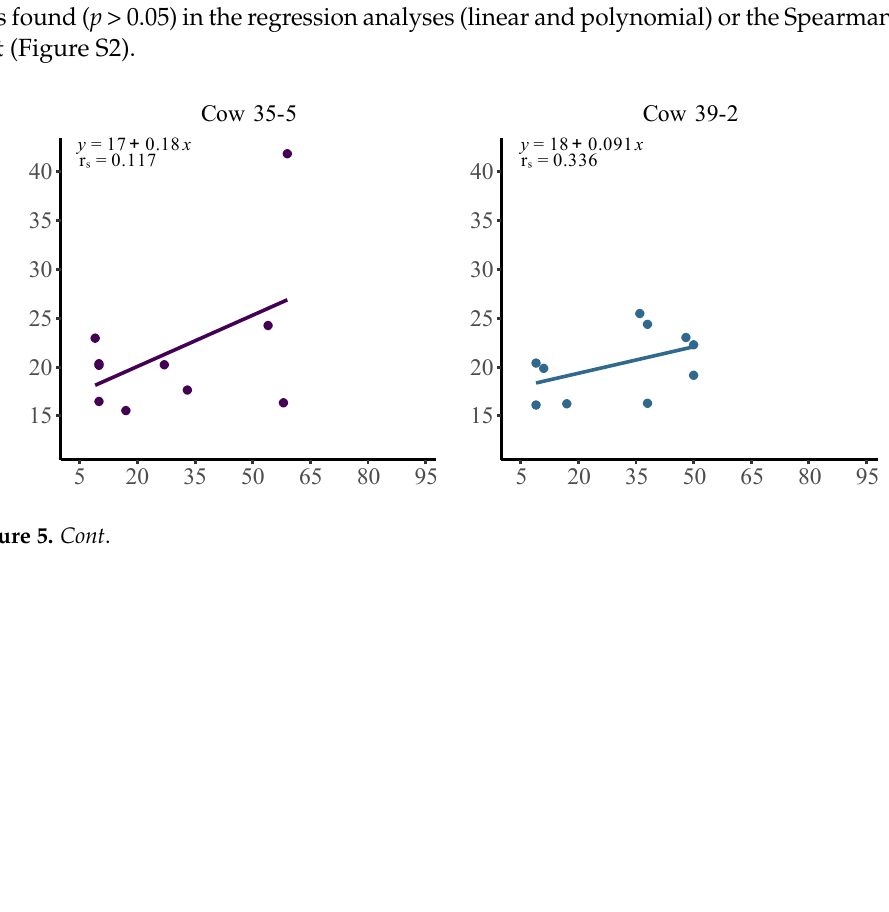
Figure 5. Linear regression of cortisol concentration in relation to the cumulative number of audi- tory warnings and electric impulses received for each individual during the study period of May 29 to June 15. The regression equation and Spearman correlation coefficient (r s ) are given in each plot. New colour for each cow. 4. Discussion Cortisol is the classical mammalian stress hormone, produced and released to the blood stream by the adrenal cortex. It is regulated with negative feedback by the adreno- corticotropic hormone (ACTH) released by the pituitary gland in response to corticotro- pin-releasing hormone (CRH) [23]. Stress, acting through the nerve system, causes an el- evation in ACTH, which, in turn, stimulates cortisol production and release from the ad- renals. The stress response, promoted by cortisol, has widespread action, including the mobility of glucose and deamination of amino acids for gluconeogenesis. Cortisol also stimulates the mobilisation of fatty acids. All these actions serve the purpose of increasing